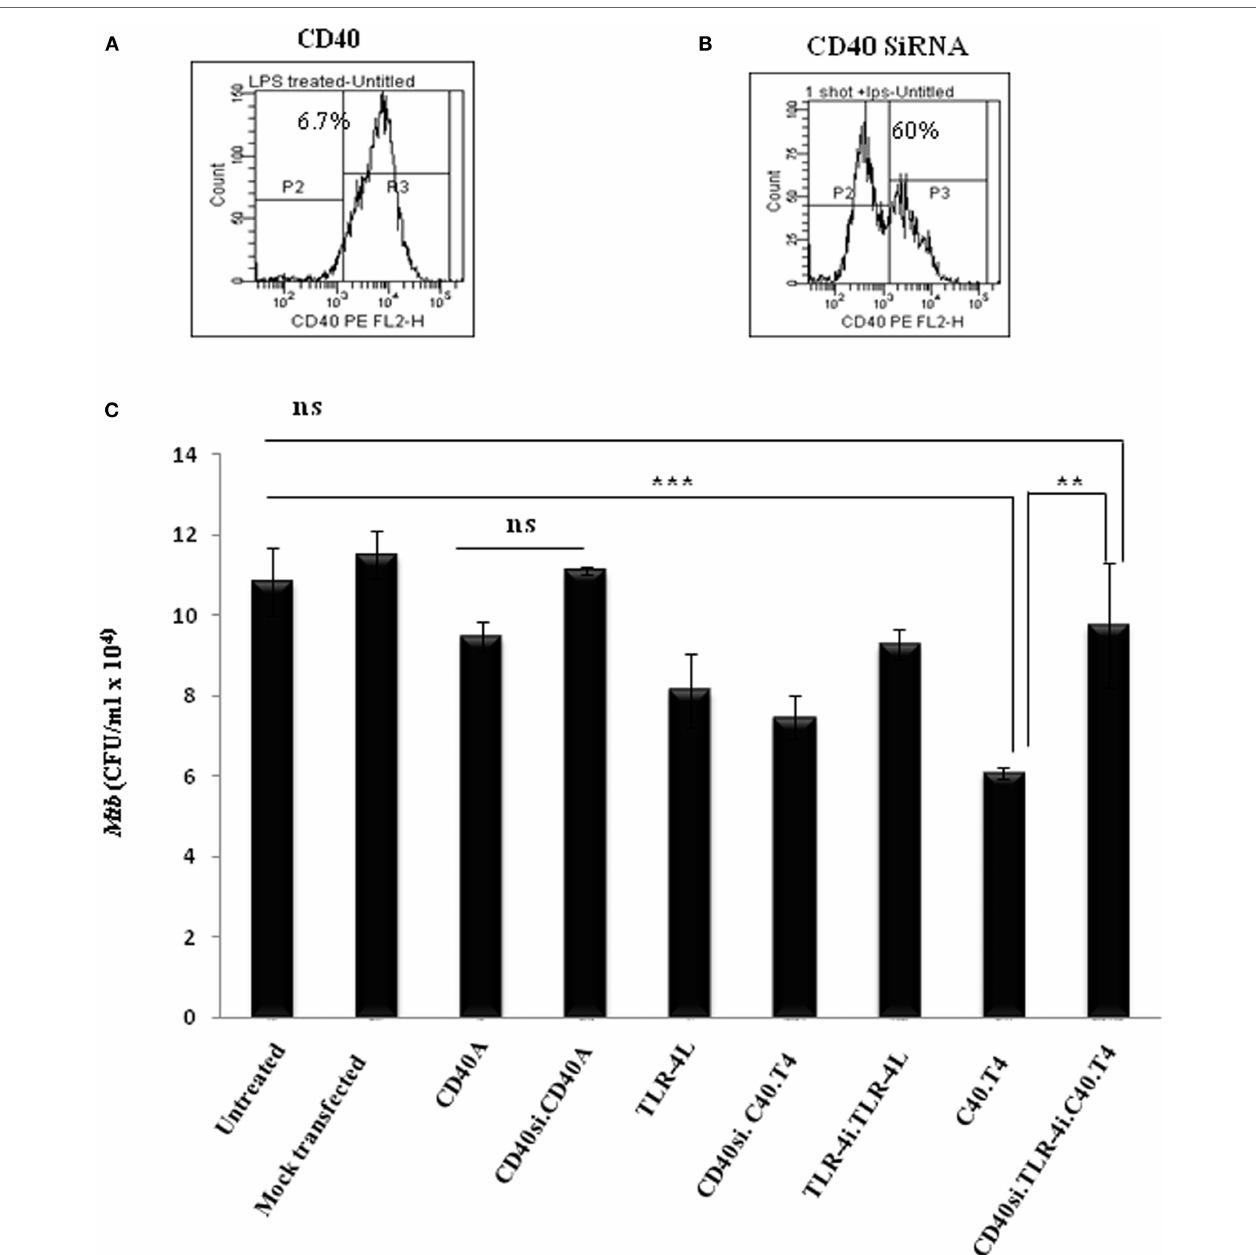
FigUre 4 | Knockdown of cD40 in the presence of Tlr-4 inhibitor (Tlr-4 i ) establishes the specificity of signaling delivered through c40.T4 in inhibiting the survival of Mtb . DCs were treated with CD40 siRNA (CD40si) for 48 h. Expression of CD40 on DCs was monitored by flowcytometry. Number in histograms indicates the percentage of CD40 negative population of DCs (a) wild-type cells; (B) CD40 knock down cells. (c) CD40 knock down and wild-type DCs were infected with Mtb followed by stimulation through C40.T4 in presence or absence of TLR-4 i for 24 h. Later, cells were lysed and bacterial burden was enumerated on 21 days by CFU counting. Data shown are mean ± SD and representative of two independent experiments. CD40si: CD40 knockdown by SiRNA; TLR-4i: TLR-4